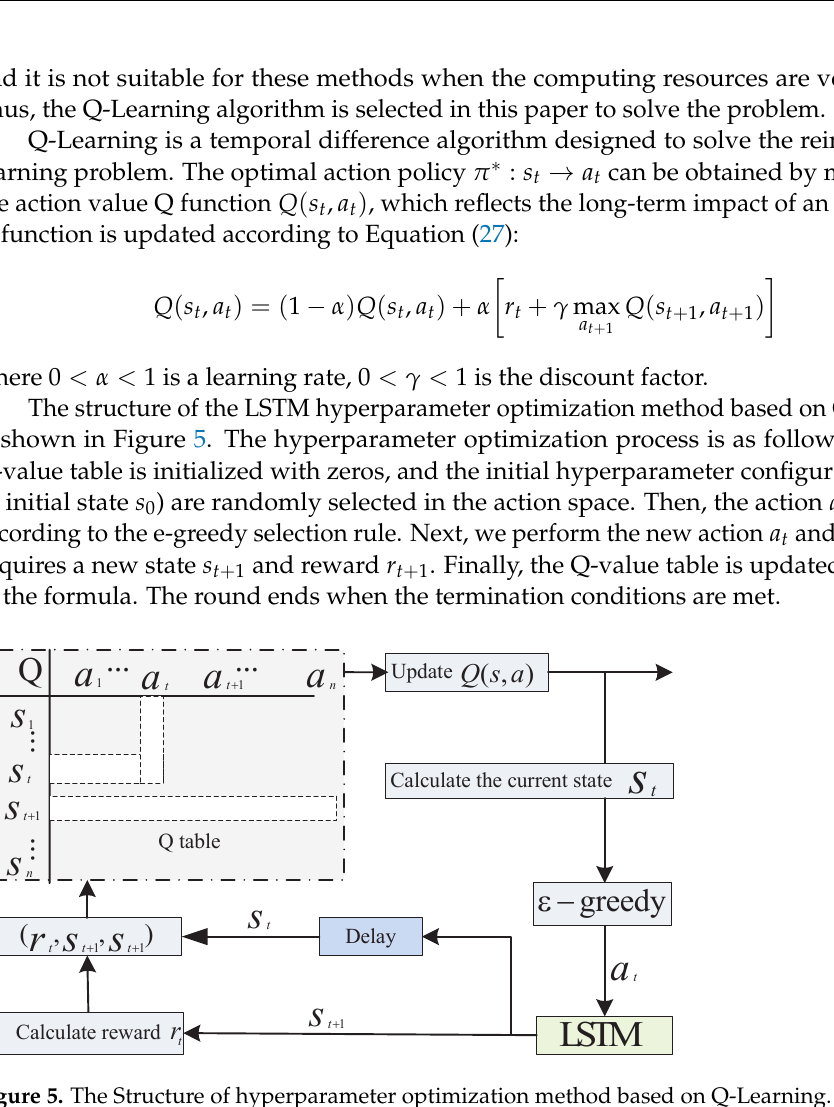
Figure 5. The Structure of hyperparameter optimization method based on